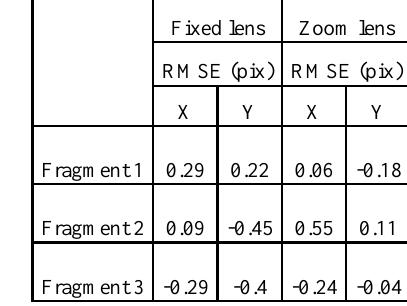
Table 6. The error values and the percentage of points greater than 2RMSE and 3RMSE for calibration with the photogrammetric method.